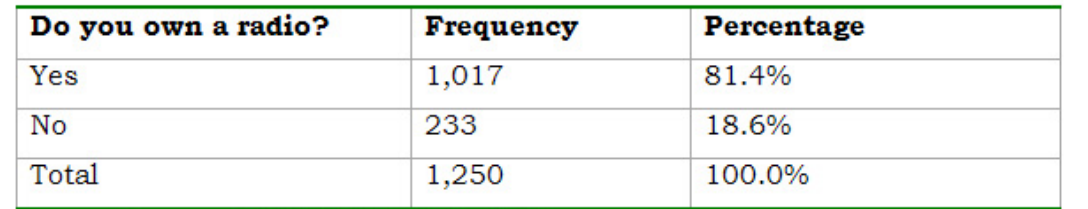
Table 4. Distribution of radios by heads and members of households in Nigeria